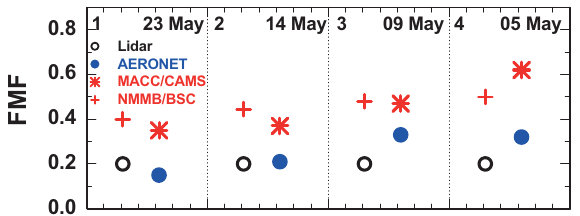
Figure 9. Comparison of modeled (MACC/CAMS, NMMB/BSC- Dust) and lidar-derived SAL dust fine-mode fraction (extinction- related FMF). AERONET sun photometer observations for the en- tire vertical column (MAL plus SAL), and thus influenced by ma- rine, dust, and smoke particles, are shown in